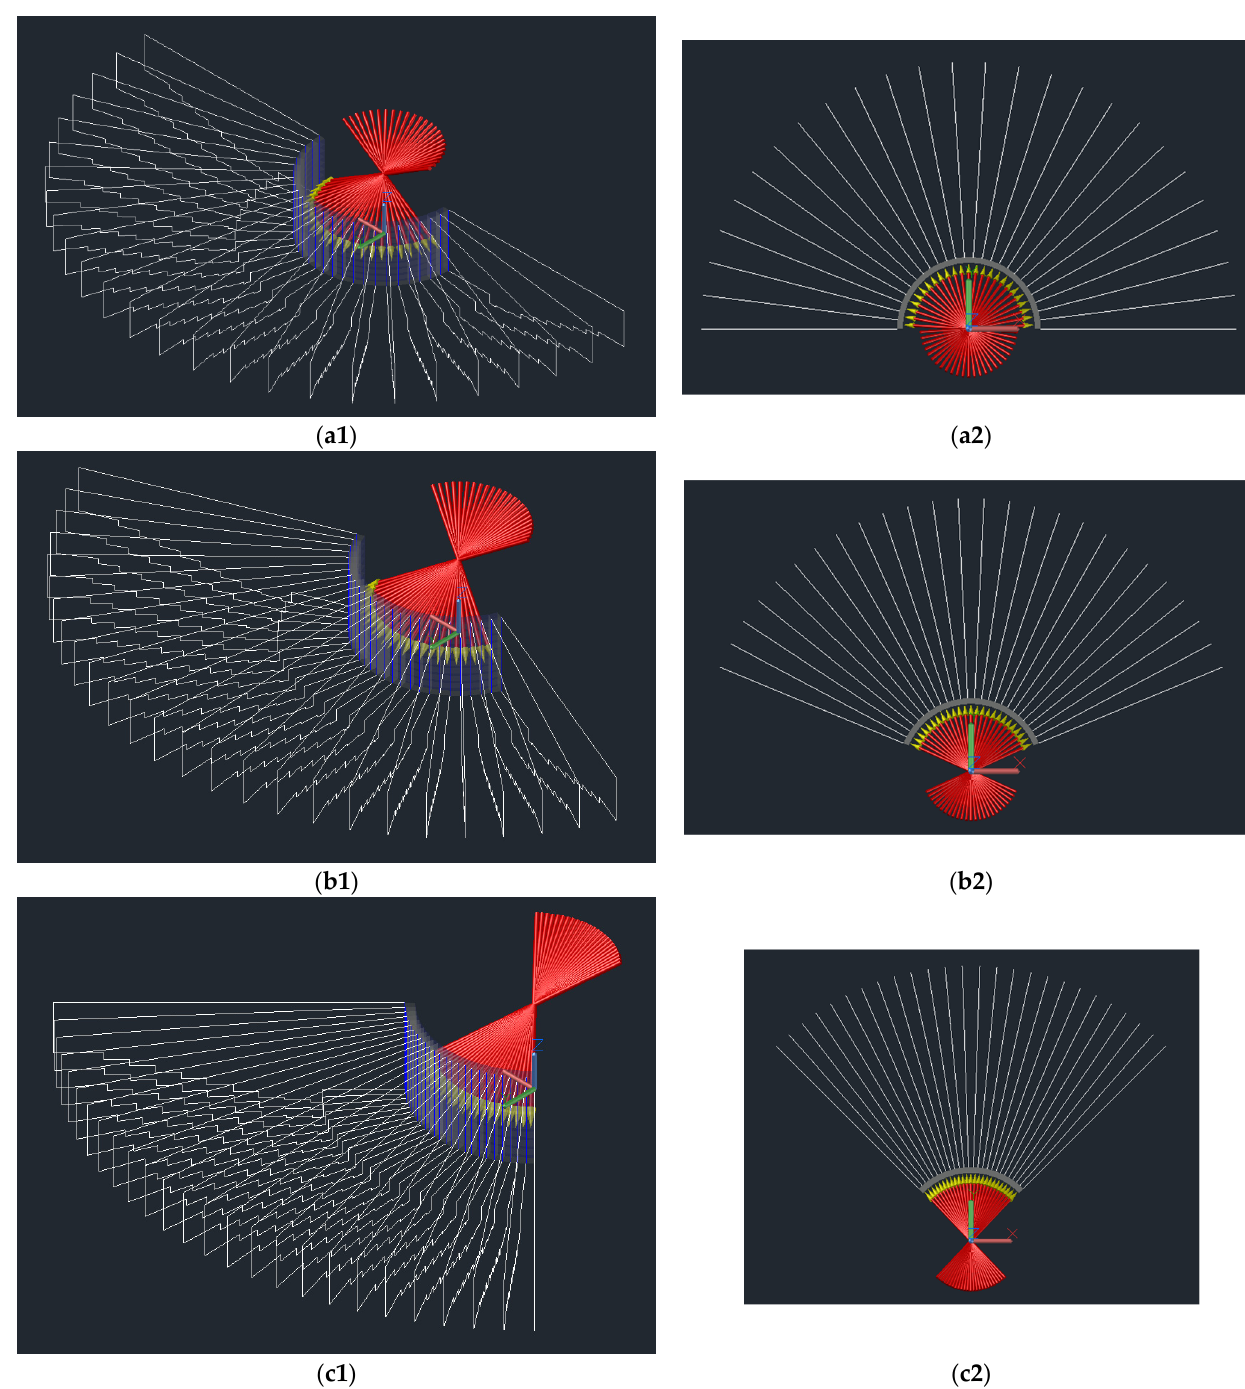
Figure 5. Scheme of the auditorium construction methodology, using a two-dimensional vertical section, and the semi-circular DSF solar radiation. ( a1 , a2 ) Case A, ( b1 , b2 ) Case B, and ( c1 , c2 ) Case C. Figures with index 1 represent the three-dimensional southeast view of the semi-circular DSF and the auditorium, while Figures with index 2 represent the top view.